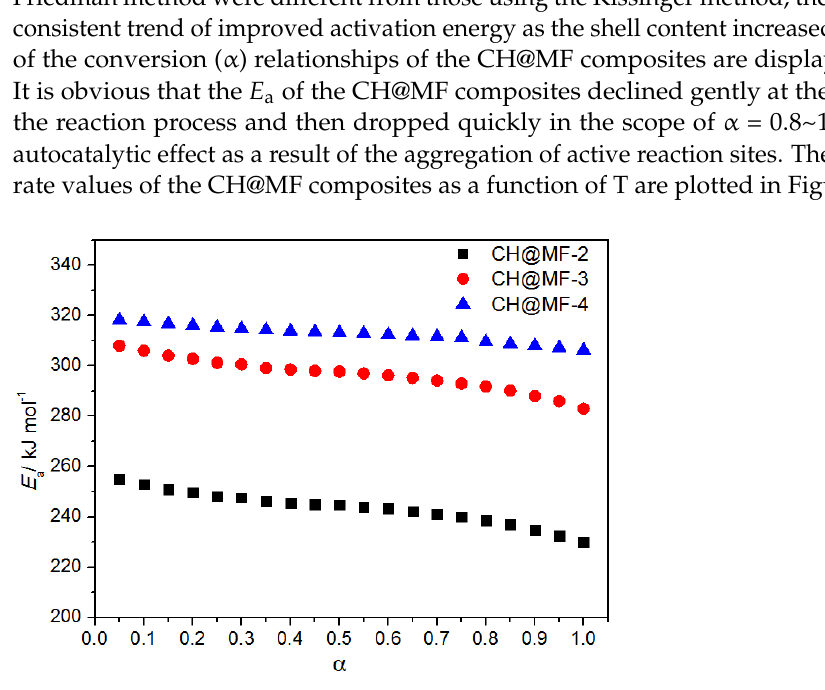
Figure 9. E a −α relationships for the thermal decomposition processes of the CH@MF composites. Figure 9. E a – α relationships for the thermal decomposition processes of the CH@MF